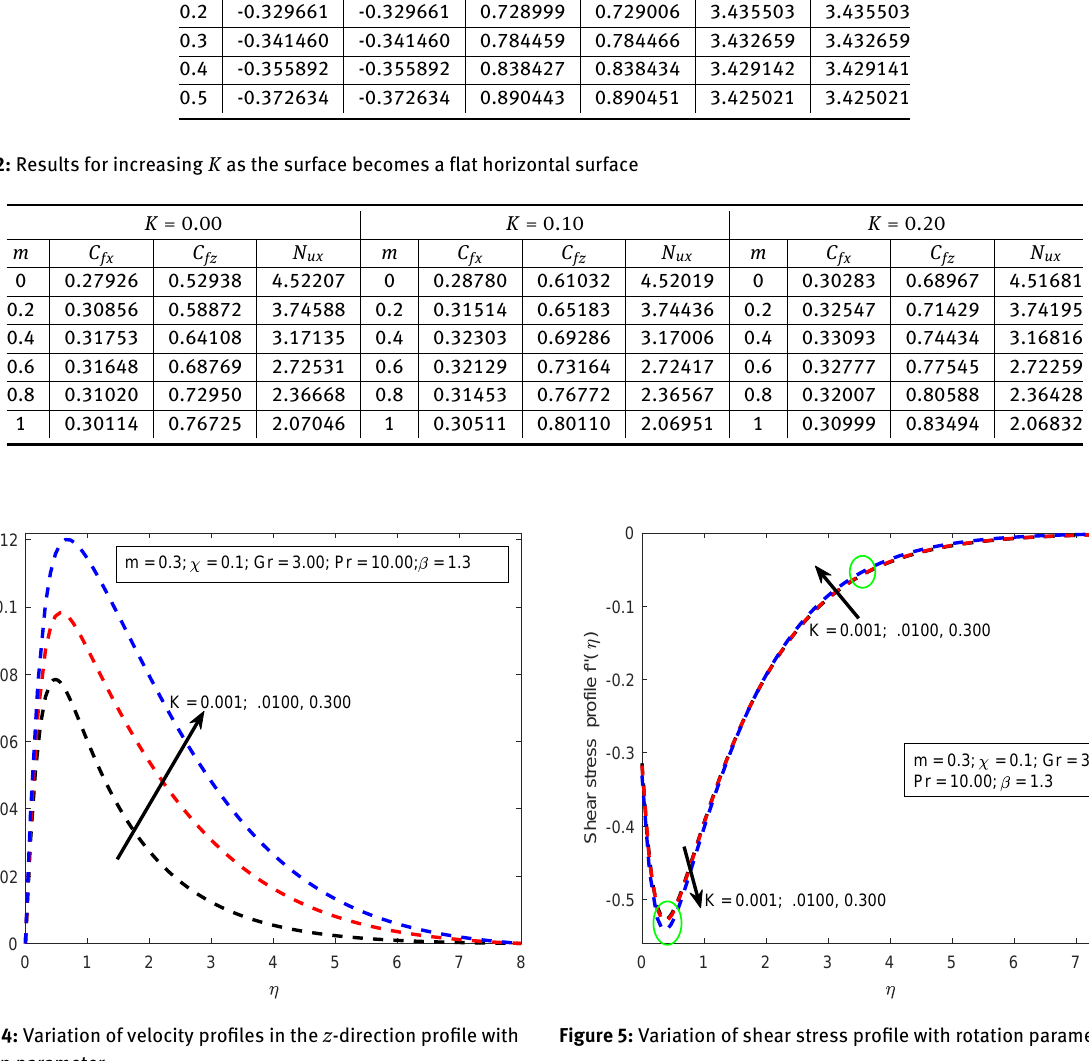
Figure 5: Variation of shear stress profile with rotation parameter rotation parameter on the shear stress; an increase in the rotationparameterleadstoadecreaseinshearstressatthe boundary layer but an increase in the shear stress at the free stream. The shear stress reaches the minimum in the boundary layer when the rotation is moderately high. In- creasing Casson fluid parameter implies decreasing yield stress and the fluid behaves as Newtonian fluid as